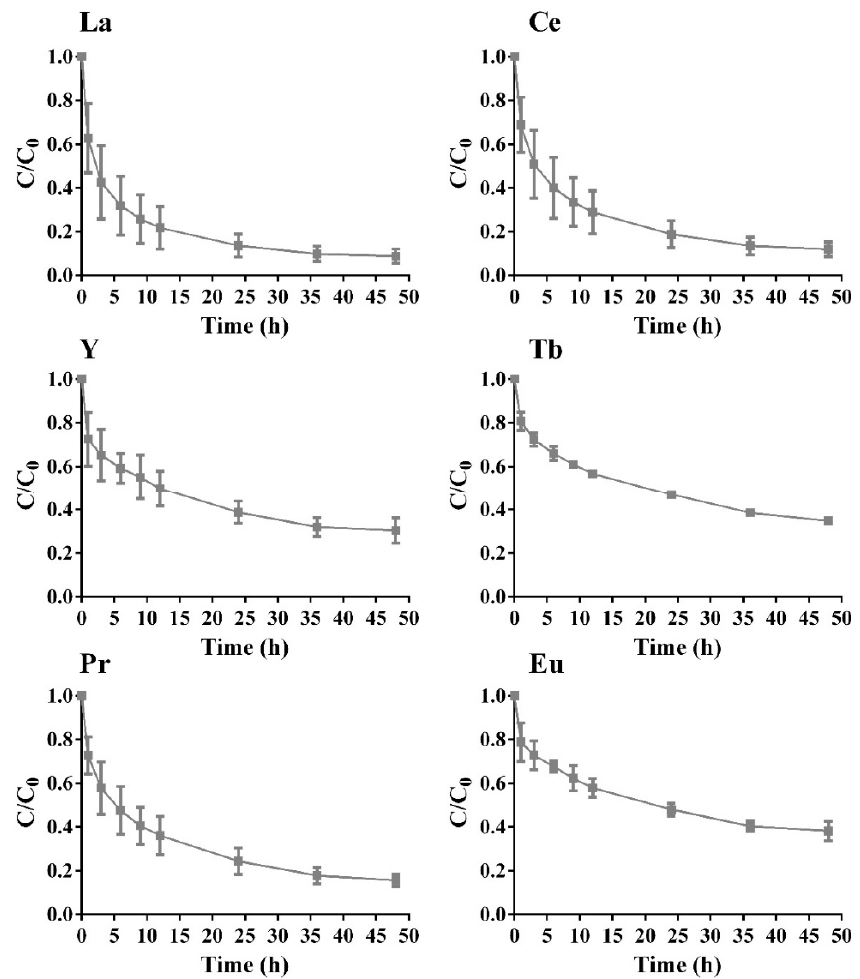
Figure 7. REE normalized concentration, C/C 0 , over time for biofilm supported on zeolite, with a sorbent concentration of 2.5 g/L and initial concentration of 20 mg/L for each REE for multi-component assays, with the respective standard deviation ( n = 2, X = 2).